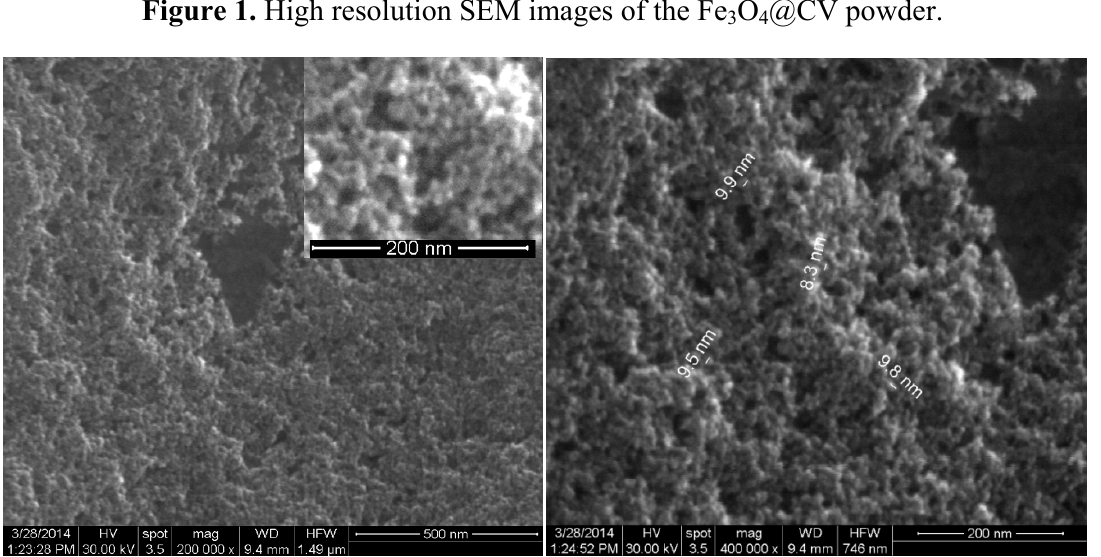
Figure 1. High resolution SEM images of the Fe